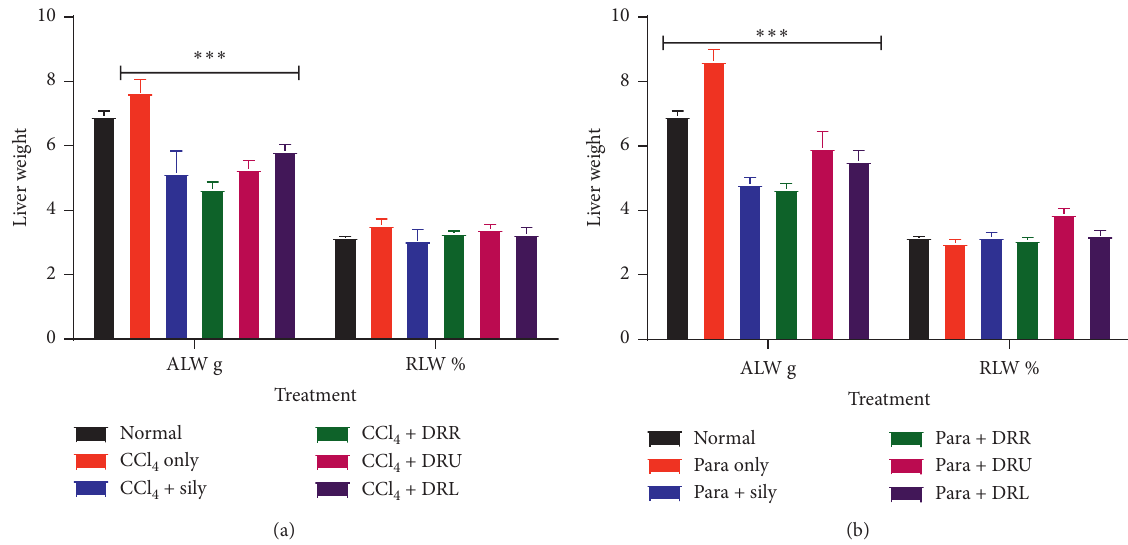
Figure 1: Effects of silymarin, DRR, DRU, and DRL on the absolute and relative liver weight of animals. ∗∗∗ P < 0 . 001 from